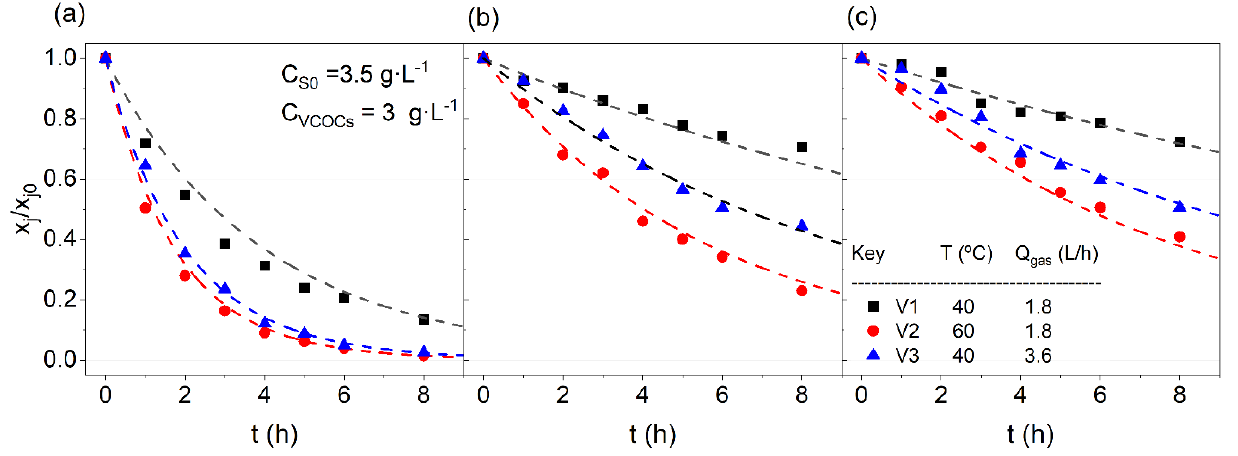
Figure 3. Volatilization of SVCOCs in the emulsion for ( a ) CB; ( b ) 1,4-DCB; ( c ) 1,2-DCB. Conditions C SVCOCs = 23.5 mmol · L − 1 ; C S0 = 3.5 g · L − 1 ; V aq = 0.3 L. SVCOCs distribution (as molar percentage) was 53% of CB, 29% of 1,2-DCB, and 18% of 1,4-DCB. Symbols depict experimental results and line values predicted using Equation (10).